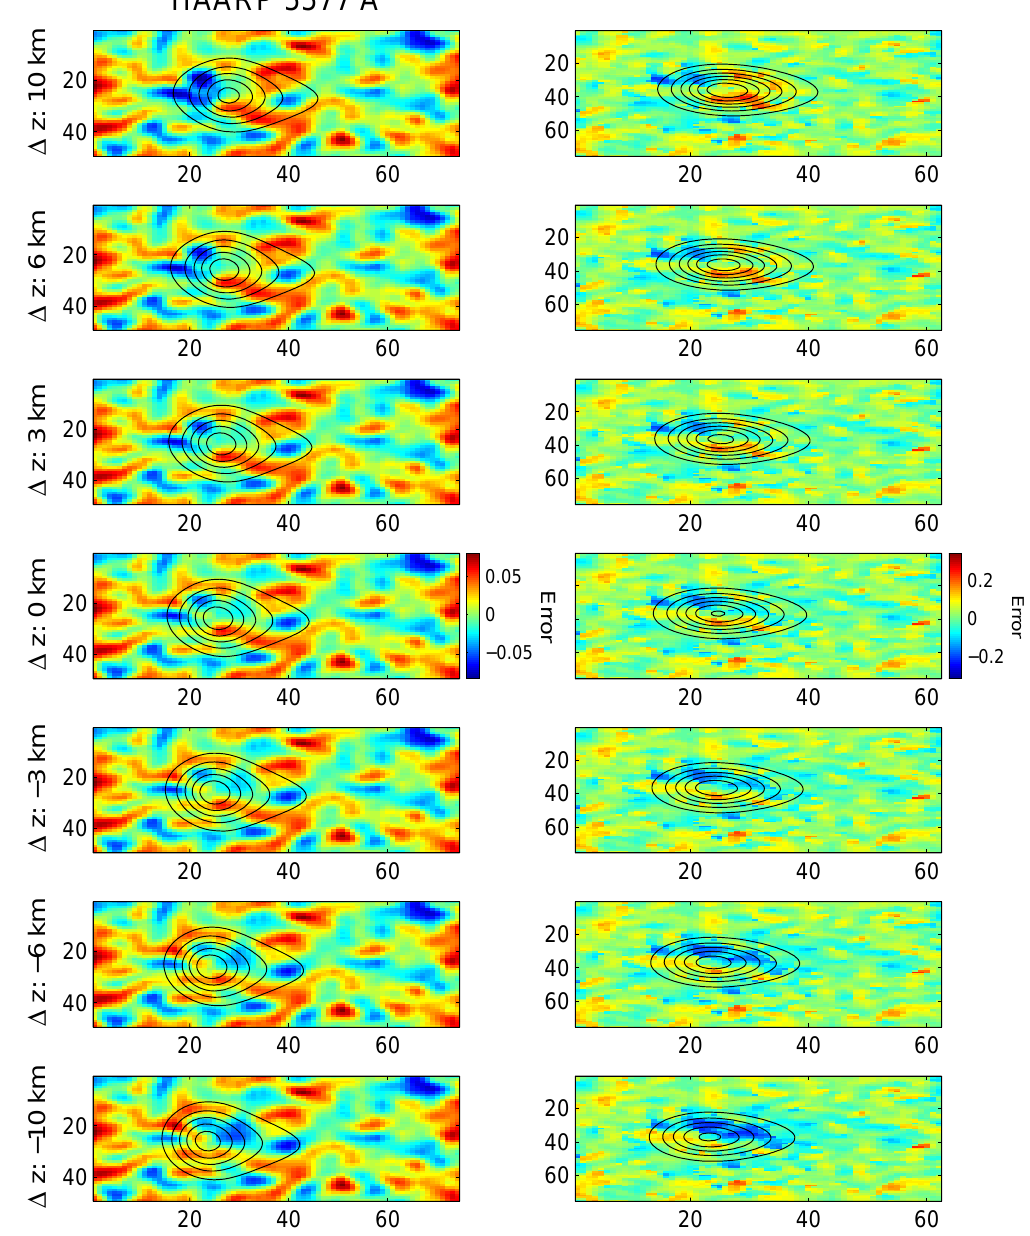
Fig. A1. HAARP image sections showing residuals between observed image and projection of three-dimensional models. In the left column for 5577 ˚A where the “blob” is shifted in altitude one can see that there is systematically negative errors at pixel (20,20) in the uppermost panel. This error decreases when the blob is lowered in altitude and for negative shifts there appears a region with negative errors around pixel (30,20). For the best fit, in the middle panel there is no systematic errors. The same systematic pattern appears for the 6300 ˚A residuals in the right column of